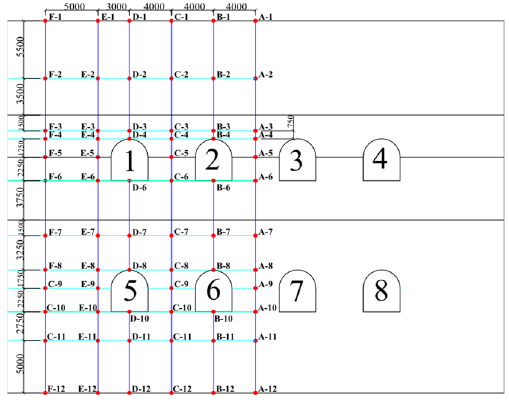
Figure 9. Monitoring points layout (unit: mm).